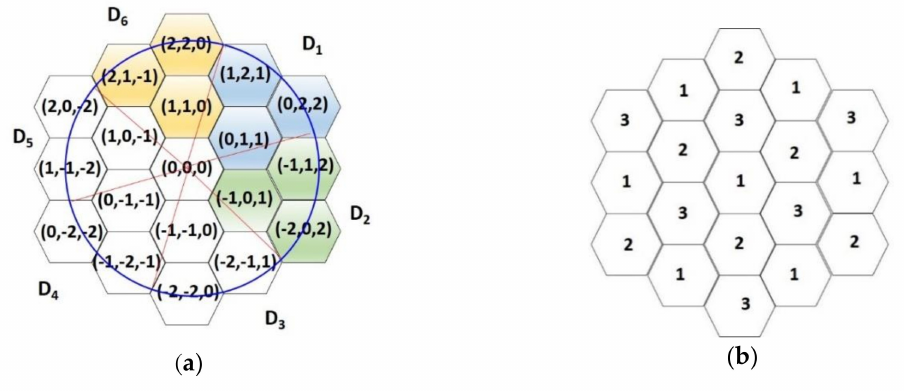
Figure 4. ( a ) Directions and neighbors of the sensor at coordinate (0,0,0); ( b ) sensor groups according to the coordinates of ( a